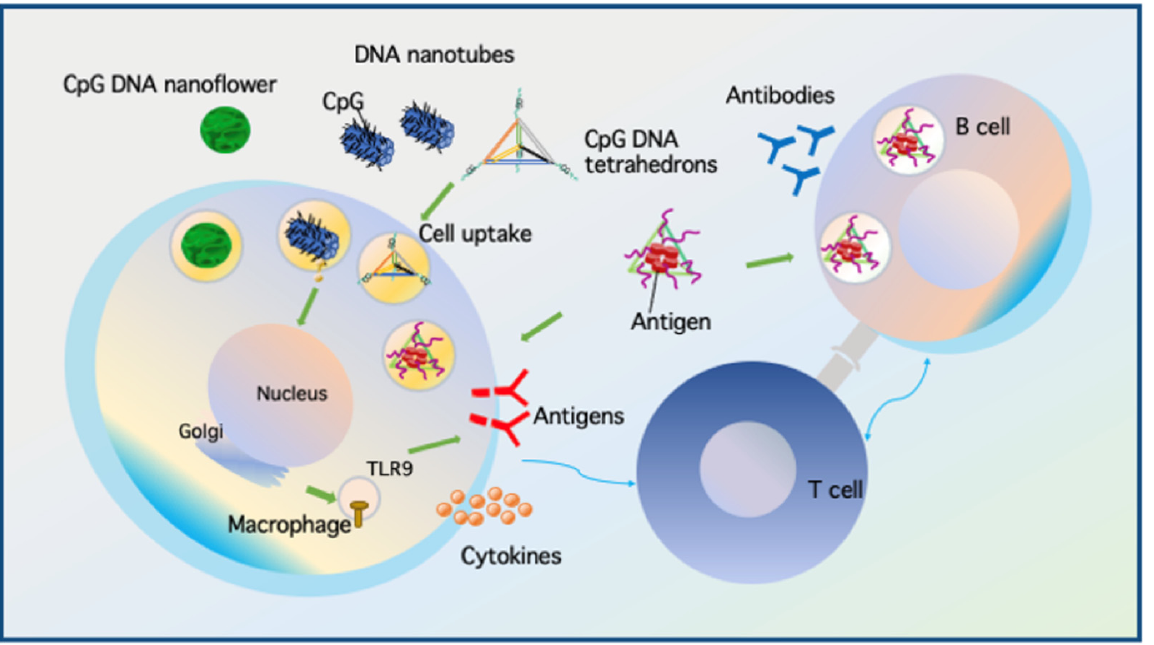
Figure 5. DNA nanostructures act as a synthetic vaccine by carrying CpG ODN with or without antigens to activate immune cells. DNS without antigens enter macrophages and deliver CpG ODN recognized by Toll-like receptor (TLR)-9 that can stimulate the cell to produce antigens and cyto- kines. DNS with antigens specifically enters B cells and non-specifically to macrophages. T cells then activate the B cell response leading to antibody production. Illustration inspired from [49].